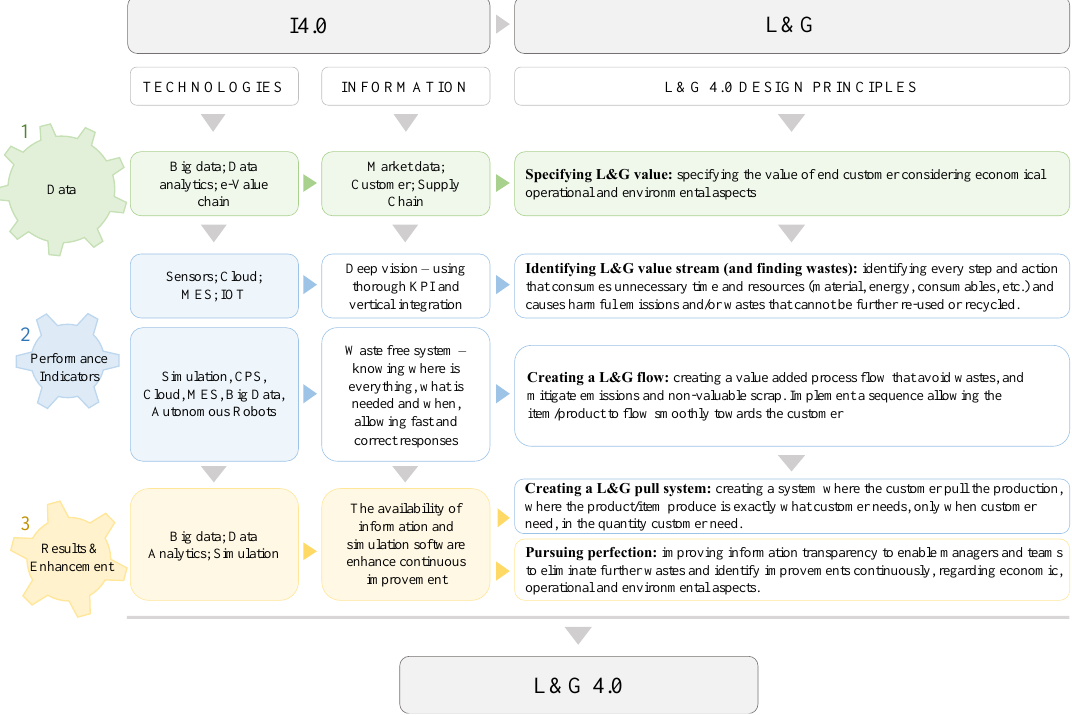
Figure 2. Relation of drivers and design principles of L&G with I4.0 technologies and